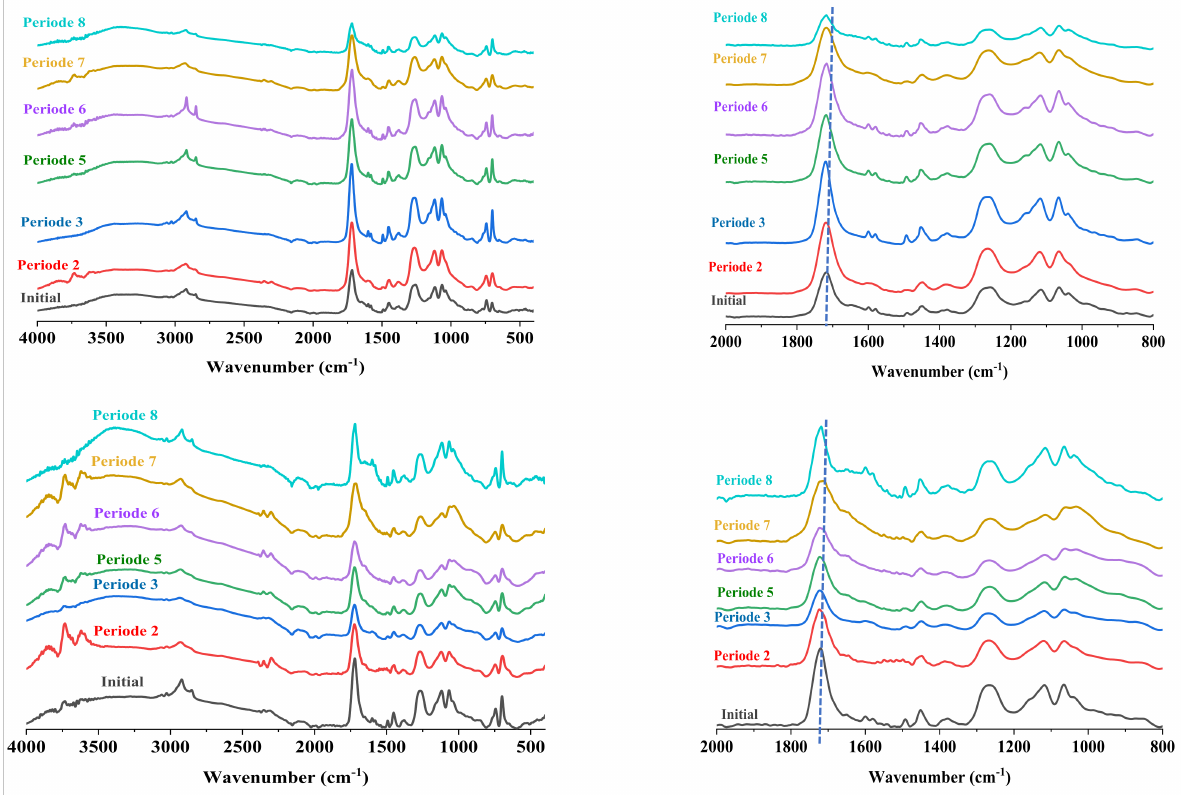
Figure 11. ATR-FTIR spectra of the morphological image of neat resin and 10% GF/15% NF composites at different solar irradiation periods (from P0 to